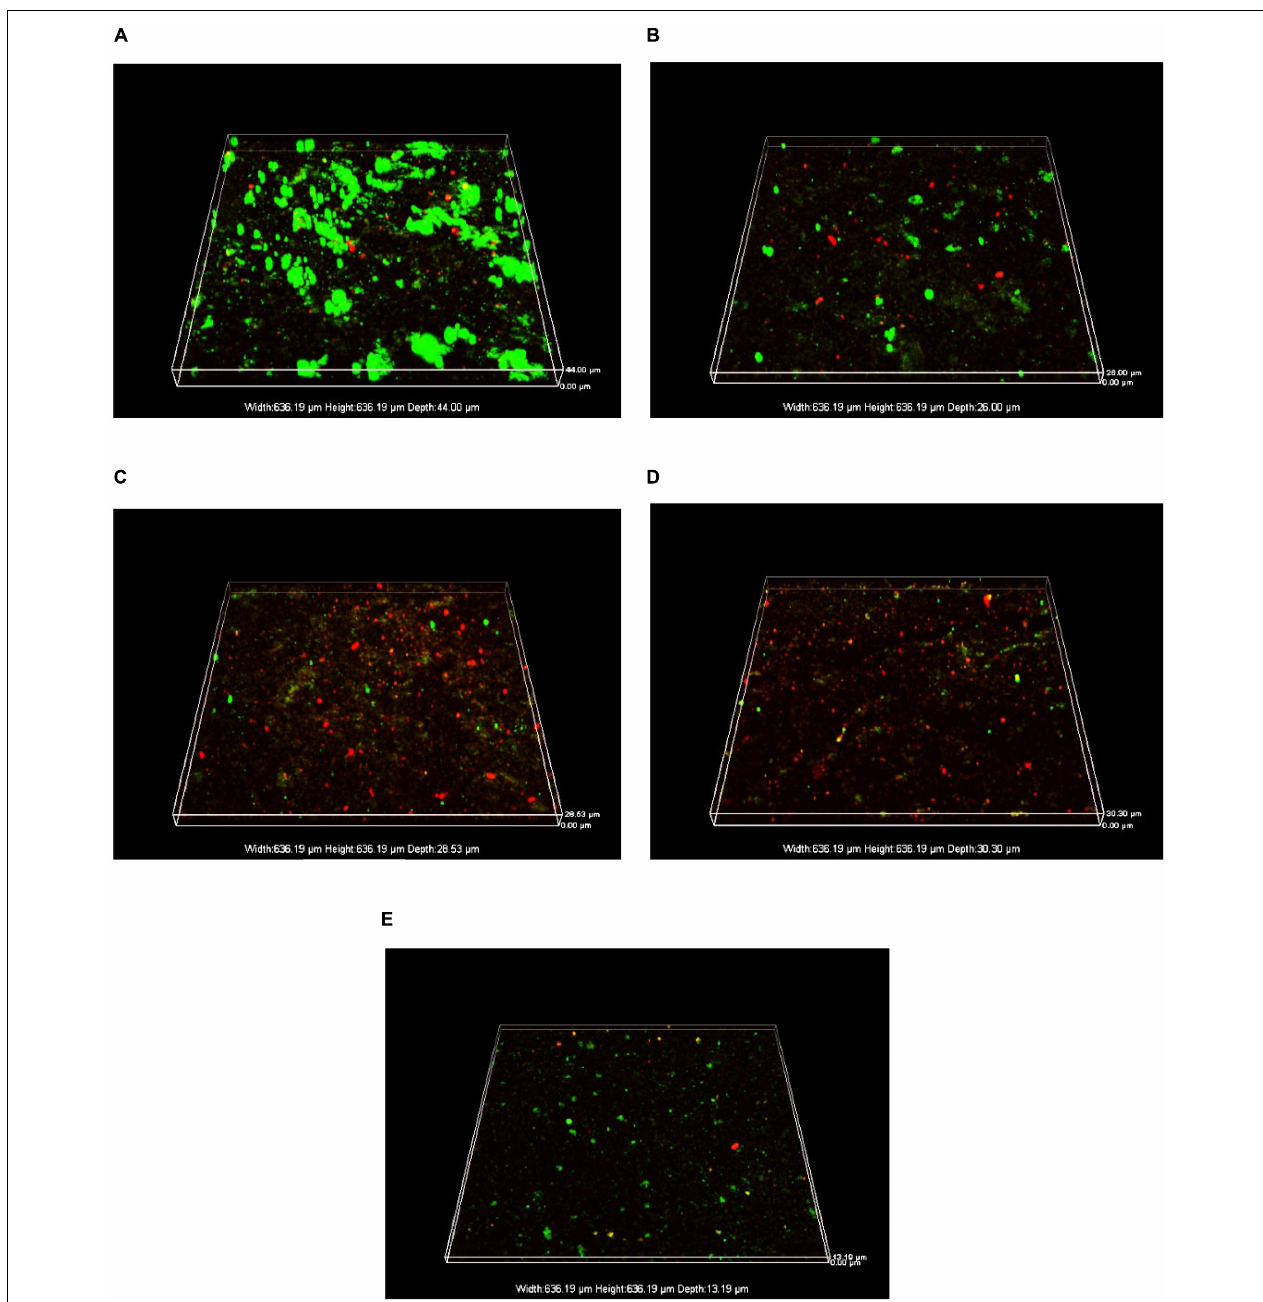
FIGURE 8 | CLSM images of biofilms after 7-day incubation on the surfaces of pyrite coupons: (A) no lithium and cobalt ions (control), (B) 2.84 g · L − 1 Li + , (C) 24.08 g · L − 1 Co 2 + , (D) 2.84 g · L − 1 Li + + 24.08 g · L − 1 Co 2 + , and (E) 2.84 g · L − 1 Li + + 24.08 g · L − 1 Co 2 + + 0.30 g · L − 1 GSH.